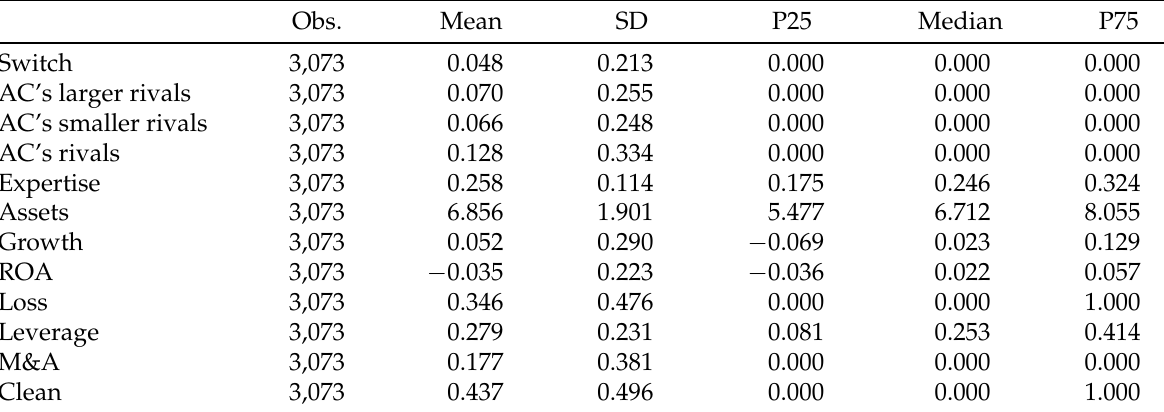
Table 5: Summary statistics and correlations: Subsequent analysis Panel A. Summary